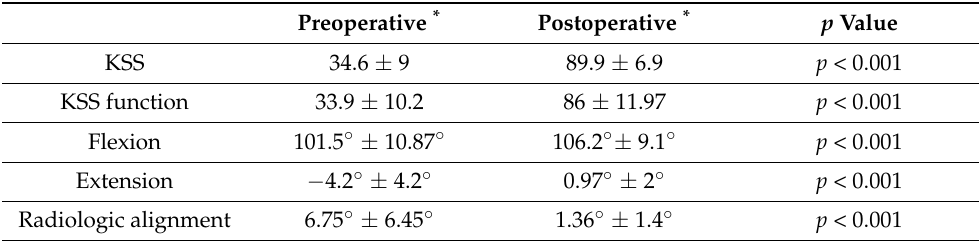
Table 2. Outcome Measures.